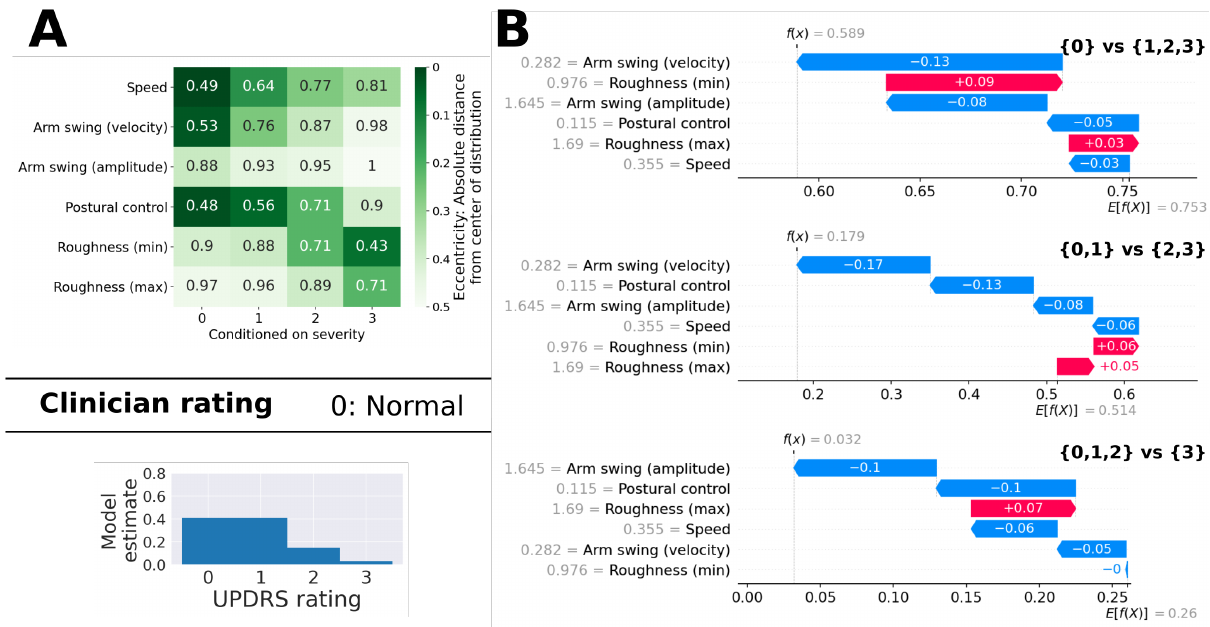
Figure 11. Example with a slight disagreement between the clinician’s rating and the model’s estimate. ( A ) The eccentricity table at the top shows a less clear structure than the example in Figure 10. While speed, arm swing, and postural control are typical of low severity ratings, the roughness of the movement was fairly typical for higher severity ratings. The Clinician gave the patient a rating of 0, while the model estimated a score of 1, although the distribution at the bottom shows that the model’s probability estimate for rating 0 was very close to the probability for rating 1. ( B ) The three figures illustrate how the model arrived at its estimates. We computed SHAP values for the example based on each of the three different binary classifiers which are part of the ordinal model. It can be seen that, in all three classifiers, all feature values “push” towards lower ratings, except the two feature values that are related to the roughness of movement. The first classifier estimated the probability of the example receiving a rating of greater than 0 as 59%. The second classifier estimated the probability of the example receiving a rating of 2 or 3 as 18%. For both of the first two classifiers, the specific value for the “arm swing (velocity)” feature was most